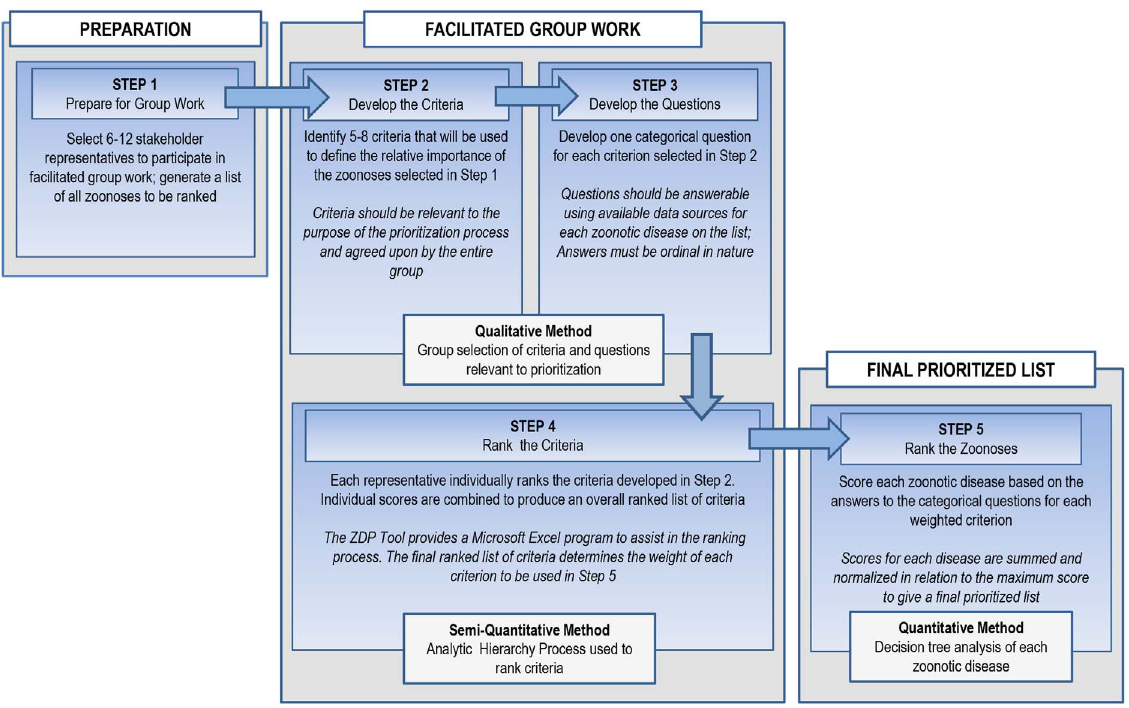
Figure 1. The five steps of the prioritization process using the One Health Zoonotic Disease Prioritization Tool.